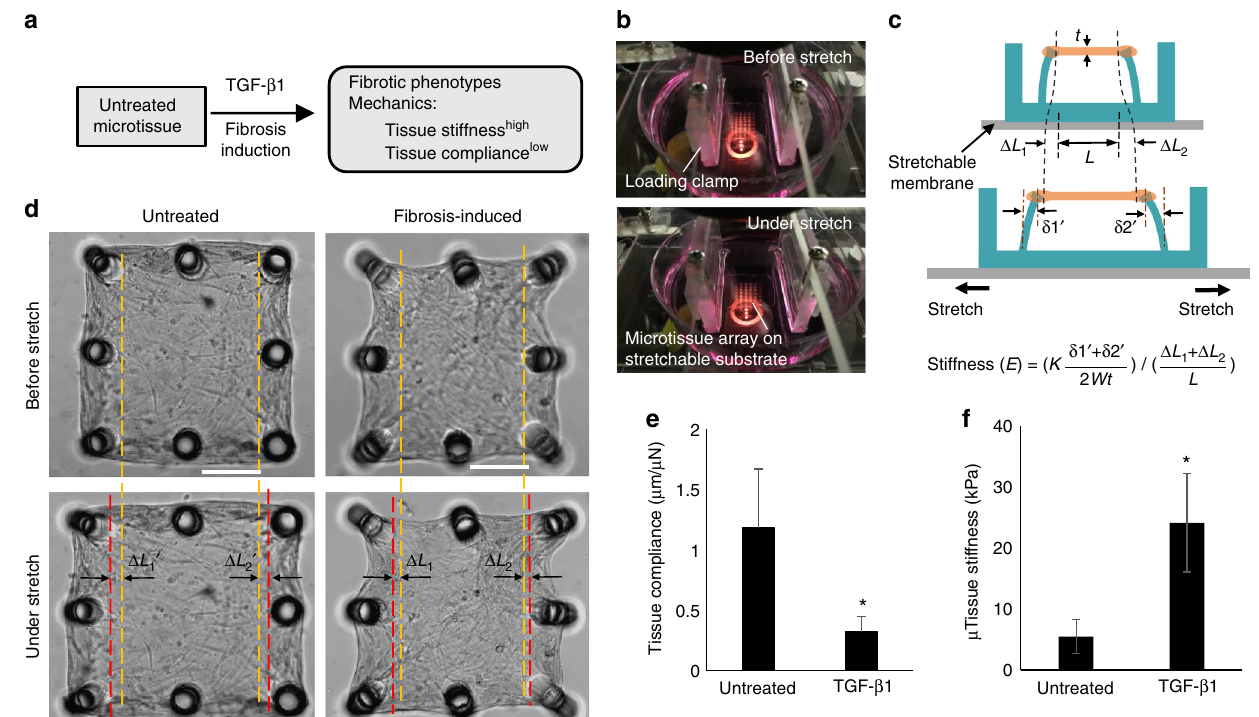
Fig. 3 Modeling fi brotic tissue stiffening in lung microtissues. a Overview of the strategy for fi brosis induction and evaluation based on the measurement of tissue stiffness and compliance. b Mechanical stretching of the membranous microtissue mimics the respiratory distention of the alveolar sac walls. Top: unstretched microtissue array was bonded to a transparent stretchable substrate, which was mounted on a loading frame directly above microscope objective. Bottom: microtissue array under stretch. c Schematic shows the principle of tissue stiffness measurement. d Phase contrast images of microtissues before and under stretching. Stretch-induced extension of TGF- β 1-treated microtissue ( Δ L 1 + Δ L 2 ) was much less than that of untreated microtissue ( Δ L 1 ′ + Δ L 2 ′ ), indicating reduced compliance for TGF- β 1-treated samples. e Plot of microtissue compliance shows a substantial decline in the compliance in TGF- β 1-treated microtissues as compared to untreated microtissues. f Plot of microtissue stiffness shows much higher stiffness developed in TGF- β 1-treated microtissues as compared to untreated microtissues. Data are reported as the mean ± SD. n ≥ 10; * P < 0.001 when compared to untreated condition by one-way ANOVA with Tukey test. Scale bar is 200 µ